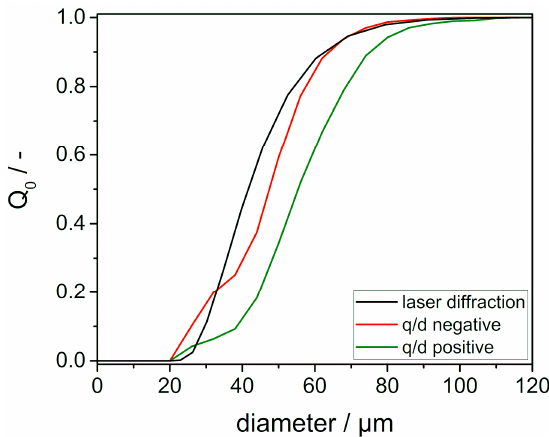
Figure 5. Number weighted sum distribution of particles above 20 µm detected in charge spectrometry (red and green) and in laser diffraction measurements (black) of virgin PA12 powder. Shown data is averaged over three (q/d), respectively five (laser diffraction) measurements.